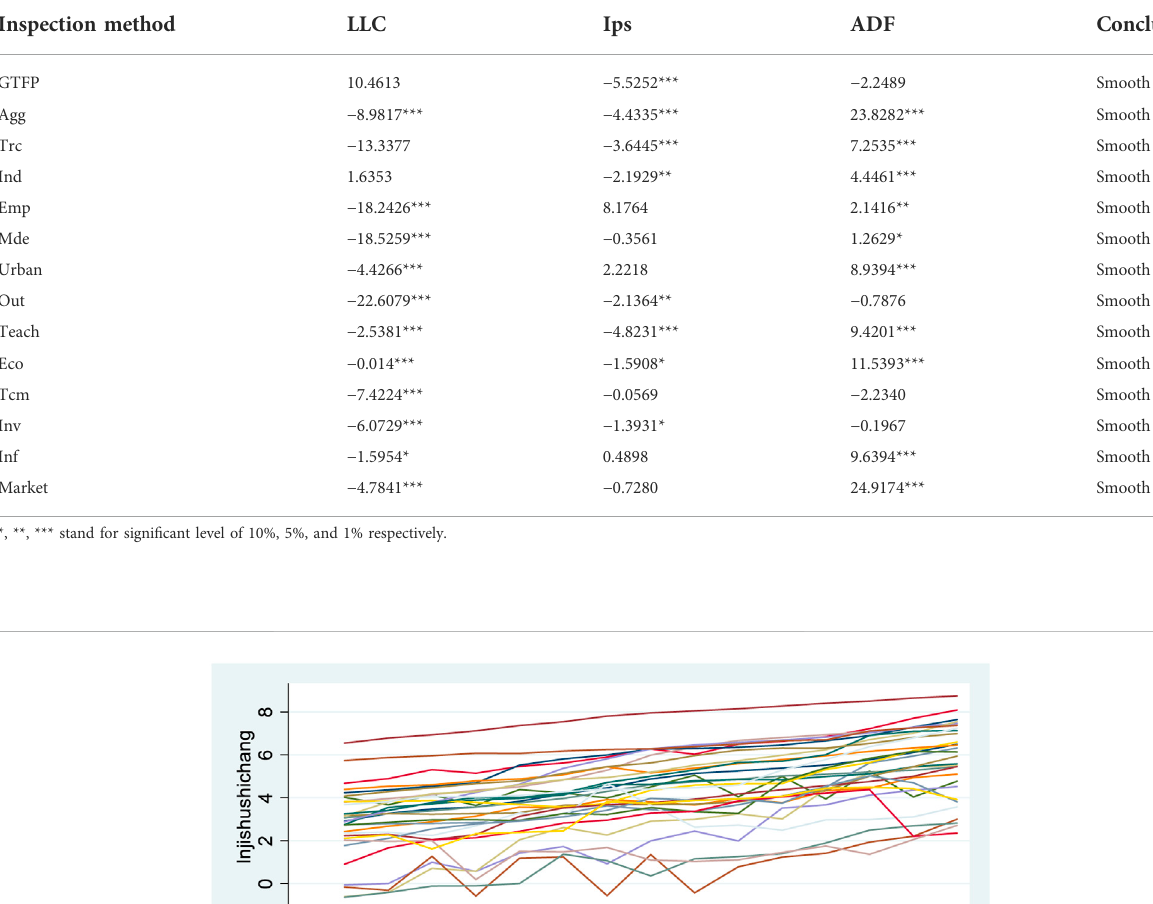
TABLE 3 Results of stationarity test.